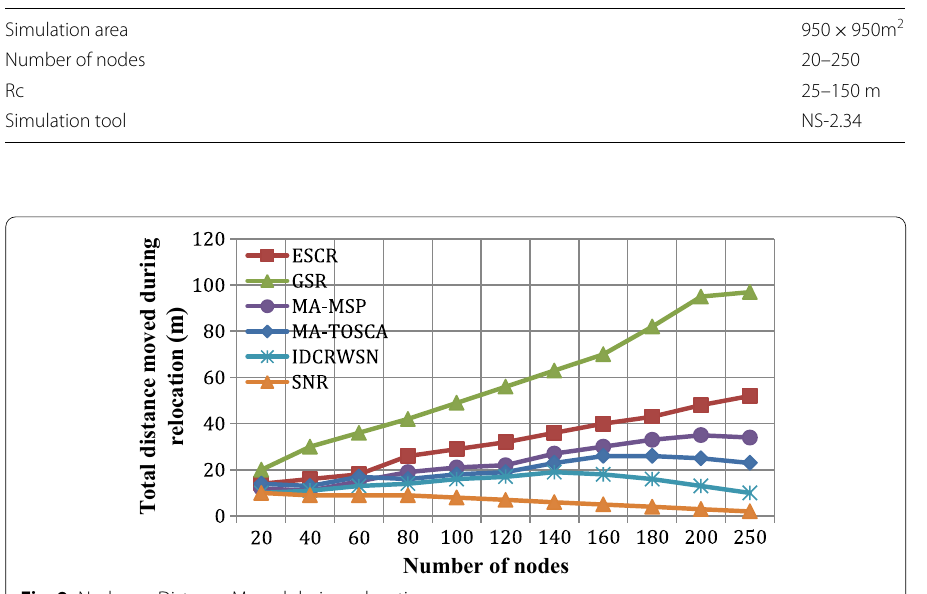
Fig. 9 Nodes vs. Distance Moved during